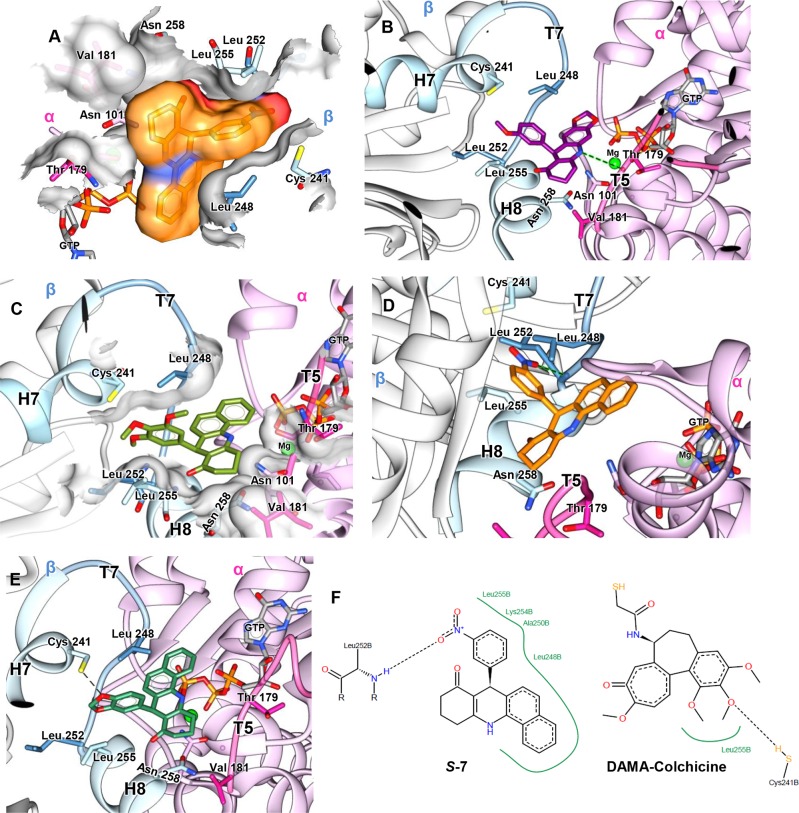
Molecular modeling studies of the acridinones series.(A), steric complementarity between the colchicine site and S-7 (B), binding mode of S-11 showing a hydrogen bond between the NH groups of acridinones and Thr α179 (C), binding mode of S-10 where the trimethoxybenzyl group occupies the hydrophobic pocket of the colchicine site (D), docking pose for S-7 with a hydrogen bond between the NO2 group and Leu β252 (E), docking pose for S-6 with a hydrogen bond between oxygen from dioxalane and Cys β241 (F), Comparison of predicted interactions between the docking pose of S-7 and the crystal structure of tubulin (PDB ID: 1SA0) and the predicted interactions between crystallographic DAMA-colchicine (PDB ID: CN2) and tubulin (PDB ID: 1SA0). These interactions were calculated using the online software PoseView [38]. The green lines represent hydrophobic interactions and the black dotted lines represent hydrogen bonds.